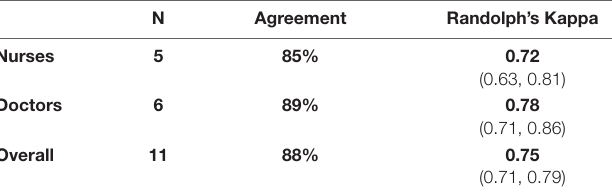
TABLE 3 | PupilScreen measures of diagnostic consistency (inter-rater